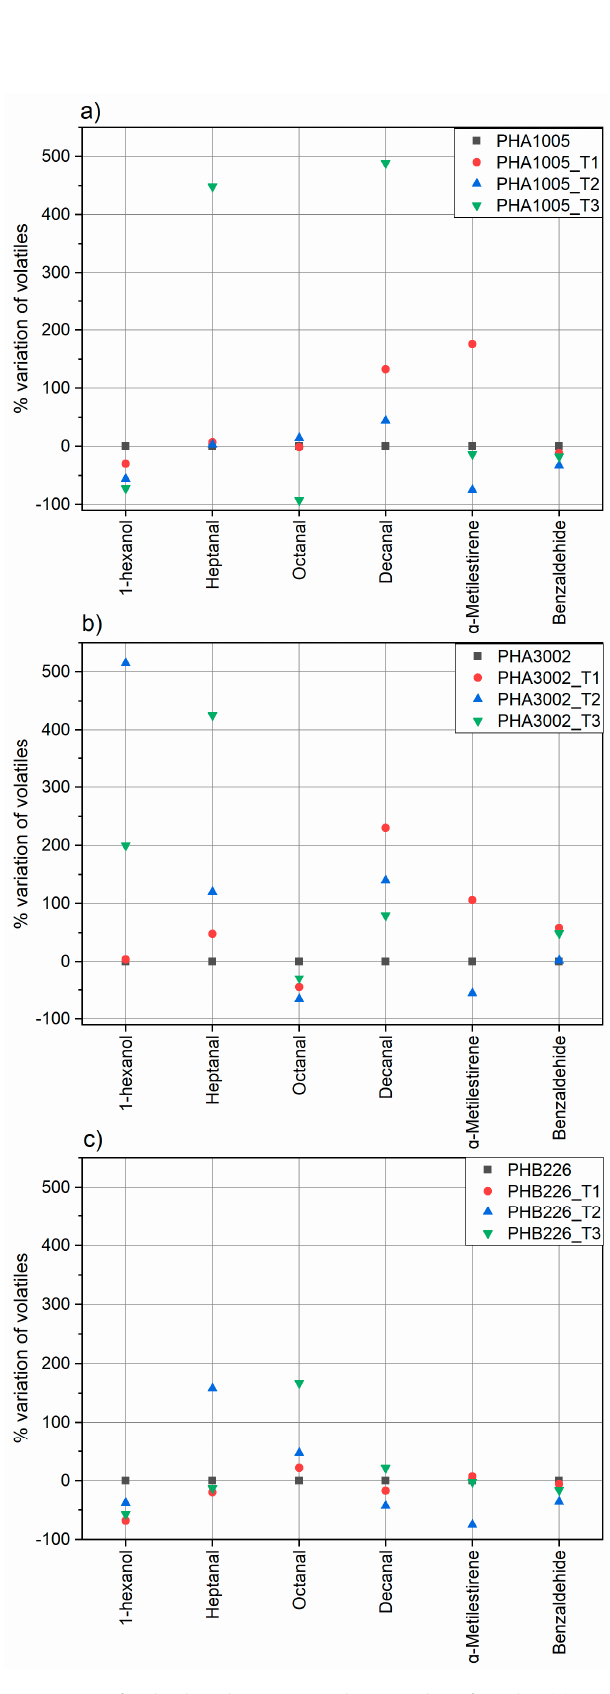
Figure 5. Percentage variation of volatile substances in the samples of study: ( a ) PHA1005, ( b ) PHA3002, ( c ) PHB226.